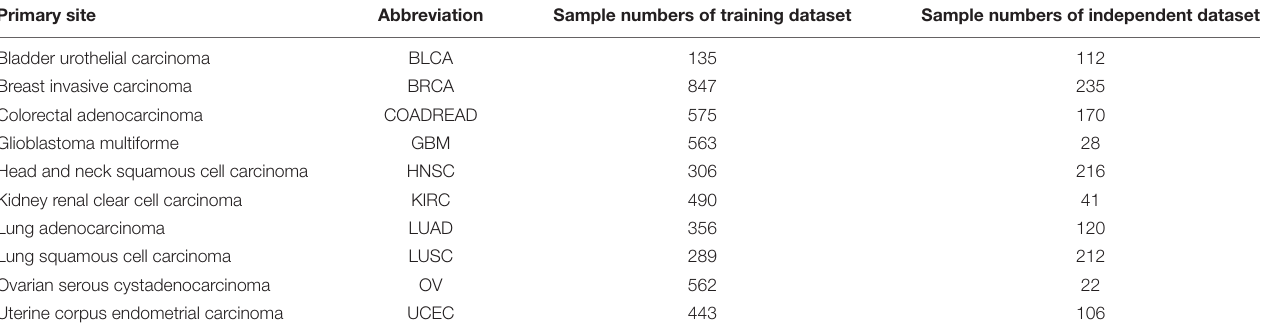
TABLE 1 | Description of the datasets.